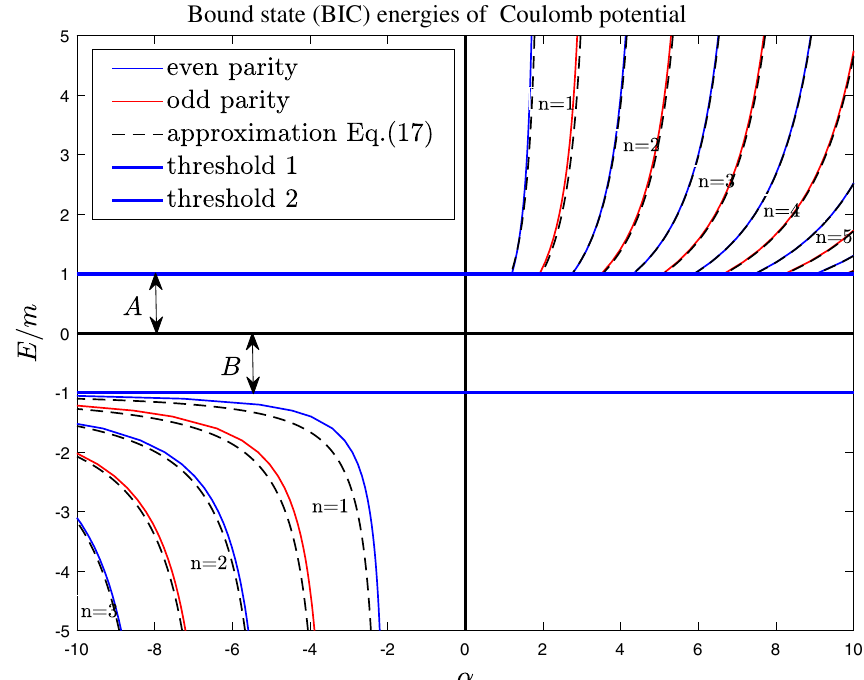
Figure 3. The bound state (BIC) energy of Coulomb potential in the case of α/ E > 0 . The solid lines are the the exact results of Eqs. (15) and (16). The black dashed lines are given by the quasi-classical approximation formula Eq. (17). In the gaps A and B, there also exist infinite (conventional) bound states whose energy satisfy (see Fig. 4 of Ref.